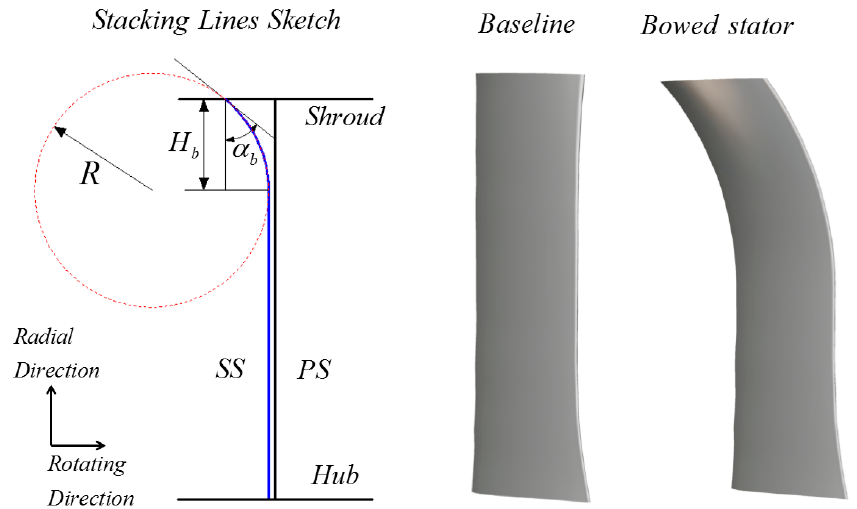
Figure 11. Stacking lines sketch and blade shapes of stator 5. SS : suction side; PS : pressure side.